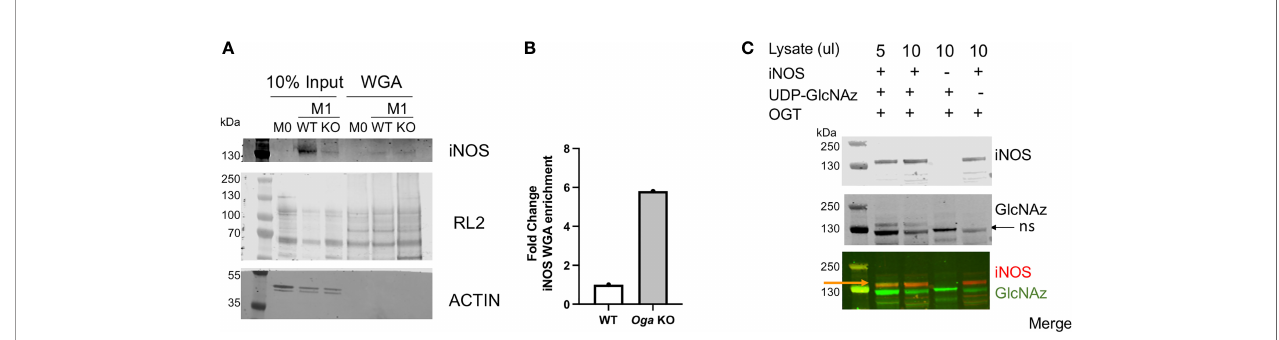
FIGURE 4 | O -GlcNAc modi fi cation of iNOS. (A, B) iNOS and O -GlcNAc (RL2) enrichment using wheat germ agglutinin from M0 and M1 polarized WT and Oga KO BMDM lysates. Lysates were pooled from cells derived from 3 independent mice of the indicated genotype. (A) Blot for iNOS and O-GlcNAc (RL2) in the input and WGA-pull down samples. (B) Quantitation of iNOS detected in the WGA enriched lanes normalized to 10% input and represented as fold change. (C) In vitro OGT assay was performed using bacterial lysates expressing recombinant full-length mouse iNOS (lanes 1,2), bacterial lysates that do not express mouse iNOS (lane 3) or with no nucleotide sugar to indicate background GlcNAz staining (lane 4). After Staudinger ligation, assays were run out on a gel and blotted, with iNOS detected by an iNOS antibody and GlcNAz modi fi cation detected with streptavidin conjugate-IRdye800. Orange arrow points to the overlap of iNOS and GlcNAz, black arrow points to non-speci fi c (ns) GlcNAz staining. For full gel image see supplemental fi gure